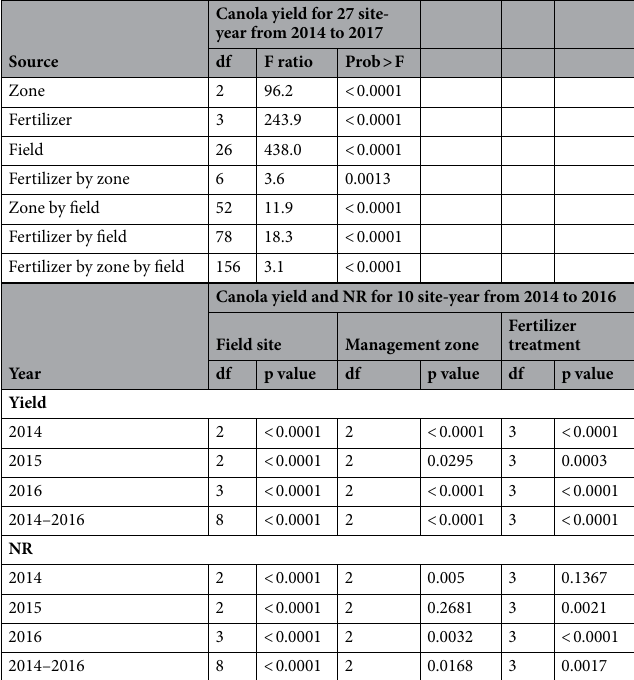
Table 2. Linear model analysis (maximum likelihood mixed model) of canola yield for 27 site-years from 2014 to 2017 and canola yield and net revenue (NR) for ten site-year from 2014 to 2016 as affected by field site, management zones, and nitrogen fertilizer in Manitoba, Saskatchewan and Alberta,